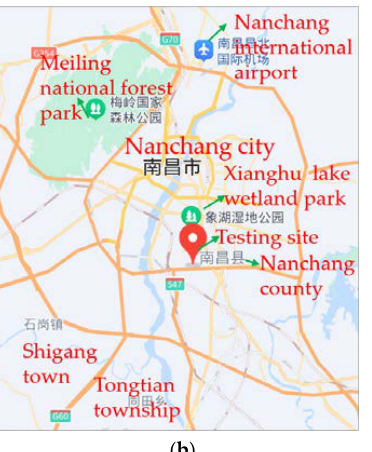
Figure 3. Sketch of monitoring points in testing site: ( a ) Sensor arrangement. ( b ) Map of testing site.